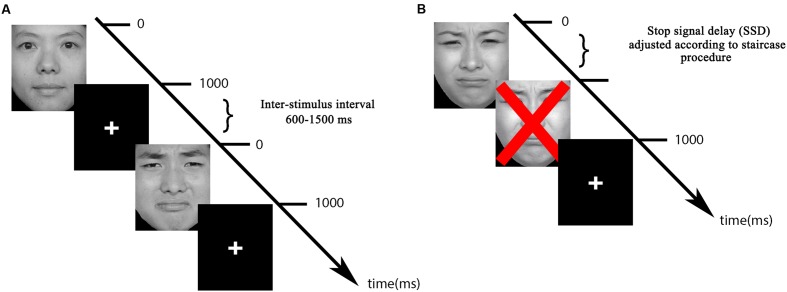
Task trials depicting one neutral, one sad Go trial (A), and one sad Stop trial (B).